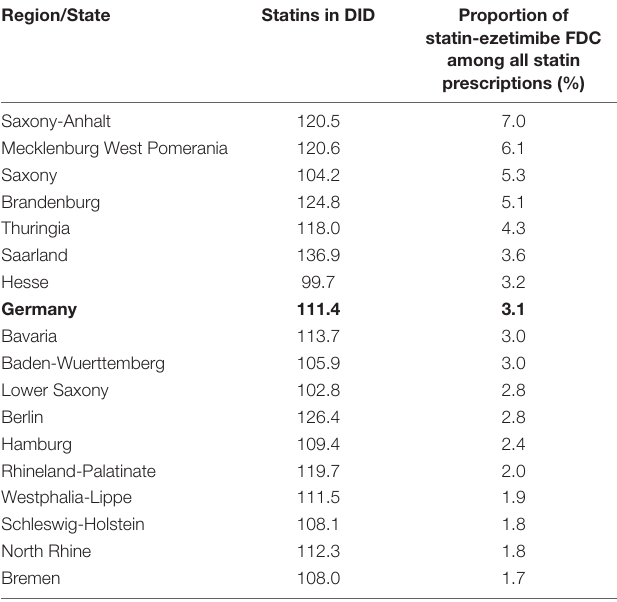
TABLE 3 | Prescription of statins in DID and proportion of statin-ezetimibe FDC 2021 by geographic region (16 federal states). Region/State Statins in DID Proportion of